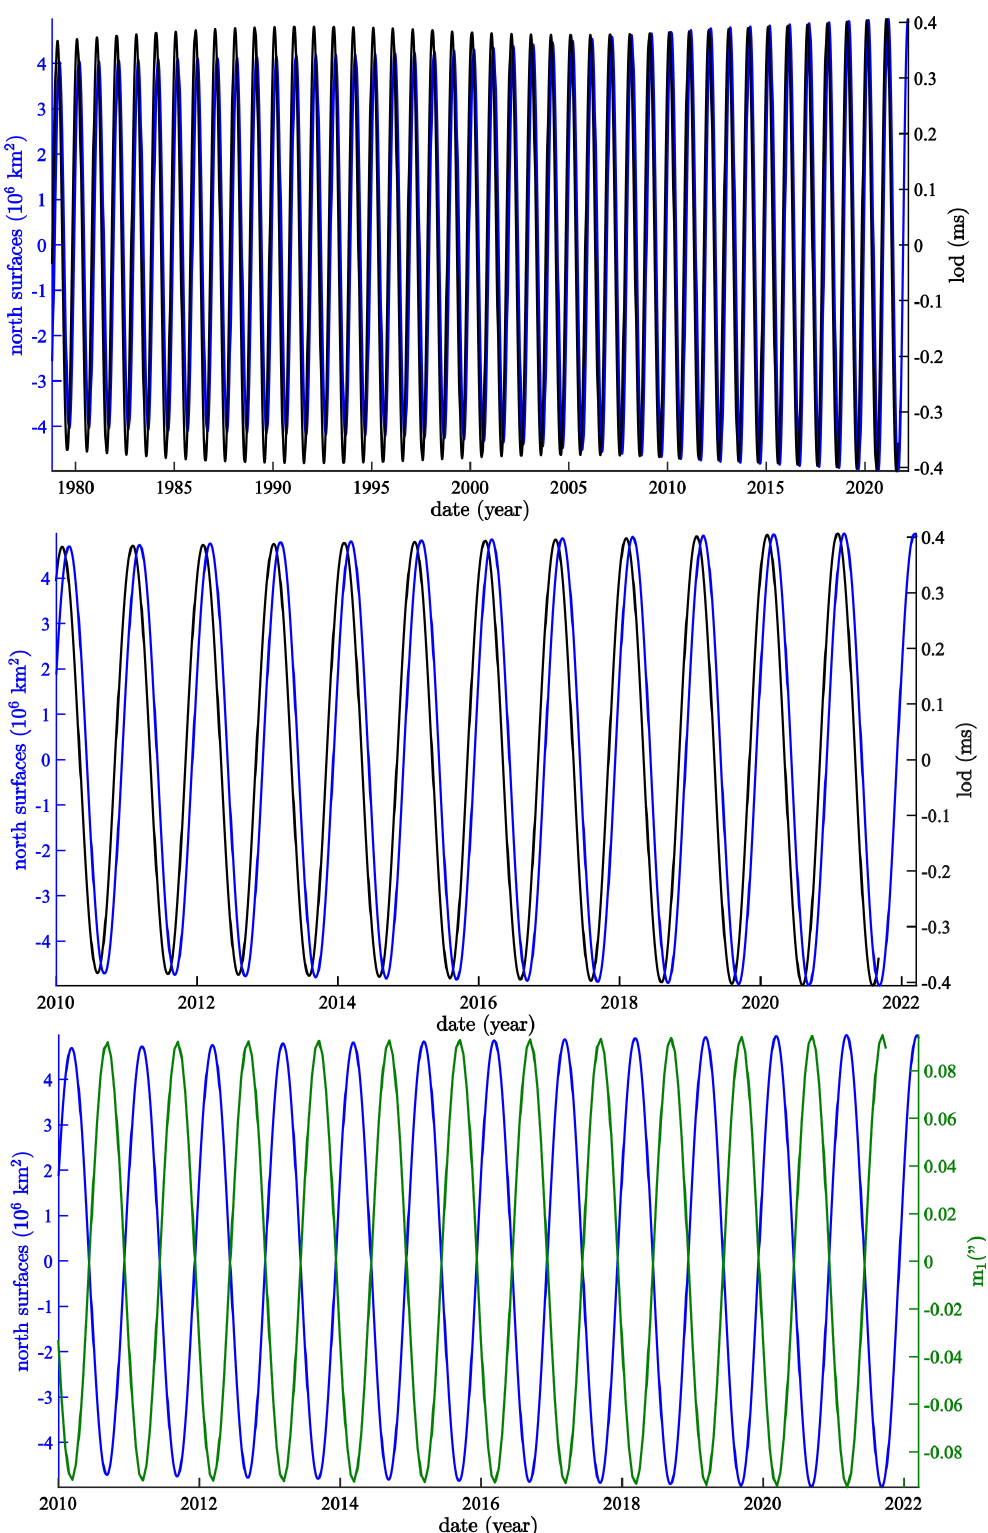
Figure 7. Comparison of SSA annual components of pole motion m 1 ( bottom , in arc seconds) and lod ( top and middle enlargement, in ms) with that of NHSI (Arctic sea ic; in 10 6 km 2 ): top = 1978–2022; middle and bottom =